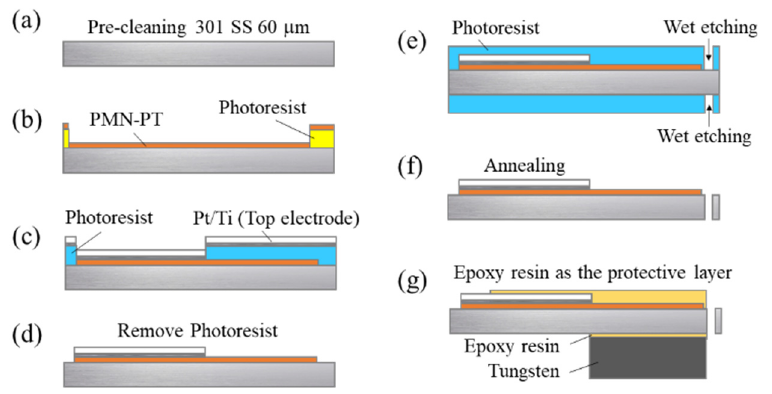
Figure 2. Schematic diagram of the fabrication process based on a stainless-steel substrate: ( a ) substrate precleaning, ( b ) PZT or PMN–PT thick-film deposition and patterning, ( c ) top electrode deposition, ( d ) lift-off process, ( e ) beam shape etching, ( f ) PZT or PMN–PT film annealing, and ( g ) protective layer coating and bonding of a proof mass.